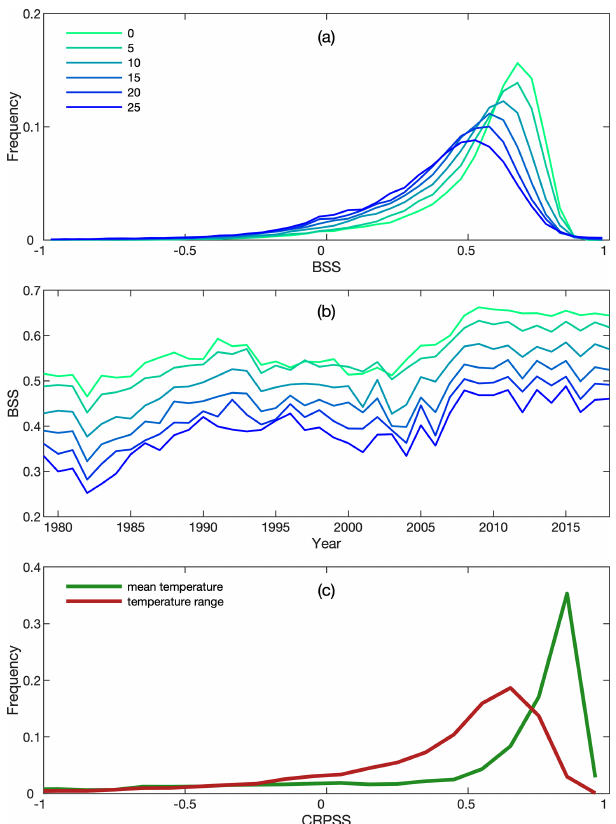
Figure 11. (a) The frequency distributions of the Brier skill score (BSS) for precipitation corresponding to rain–no-rain thresholds from 0 to 25mmd − 1 . (b) The distributions of BSS for precipitation from 1979 to 2018. For each year, the median value of all stations is used. (c) The frequency distributions of the continuous ranked prob- ability skill score (CRPSS) for daily mean temperature and daily temperature